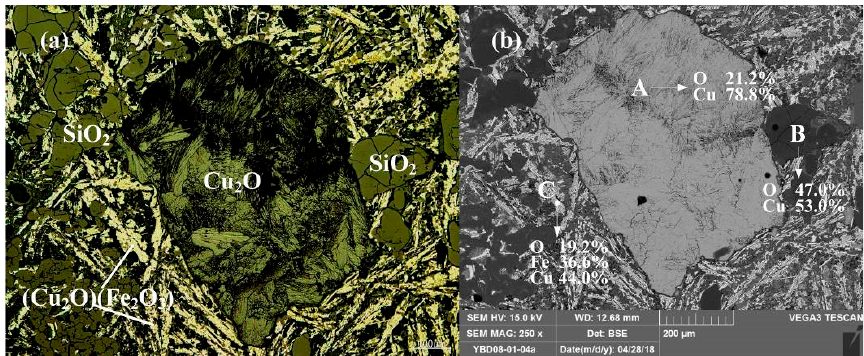
Figure 14. Optical micrograph ( a ) and SEM backscattered electron image ( b ) of YBD08. Sample YBD11: (Na, Mg, Fe) O · Fe 2 O 3 , Cu 2 O (cuprite), and CuSiO 3 · 2H 2 O (chrysocolla) were detected. No metallic copper particles were observed under the metallographic microscopy. As shown in Figure 15.